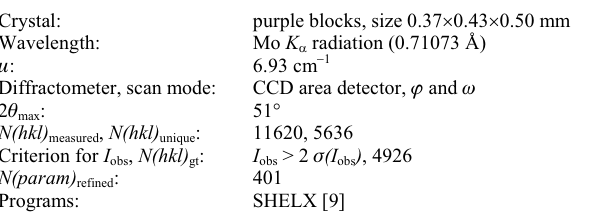
Table 2. Atomic coordinates and displacement parameters (in Å 2 )